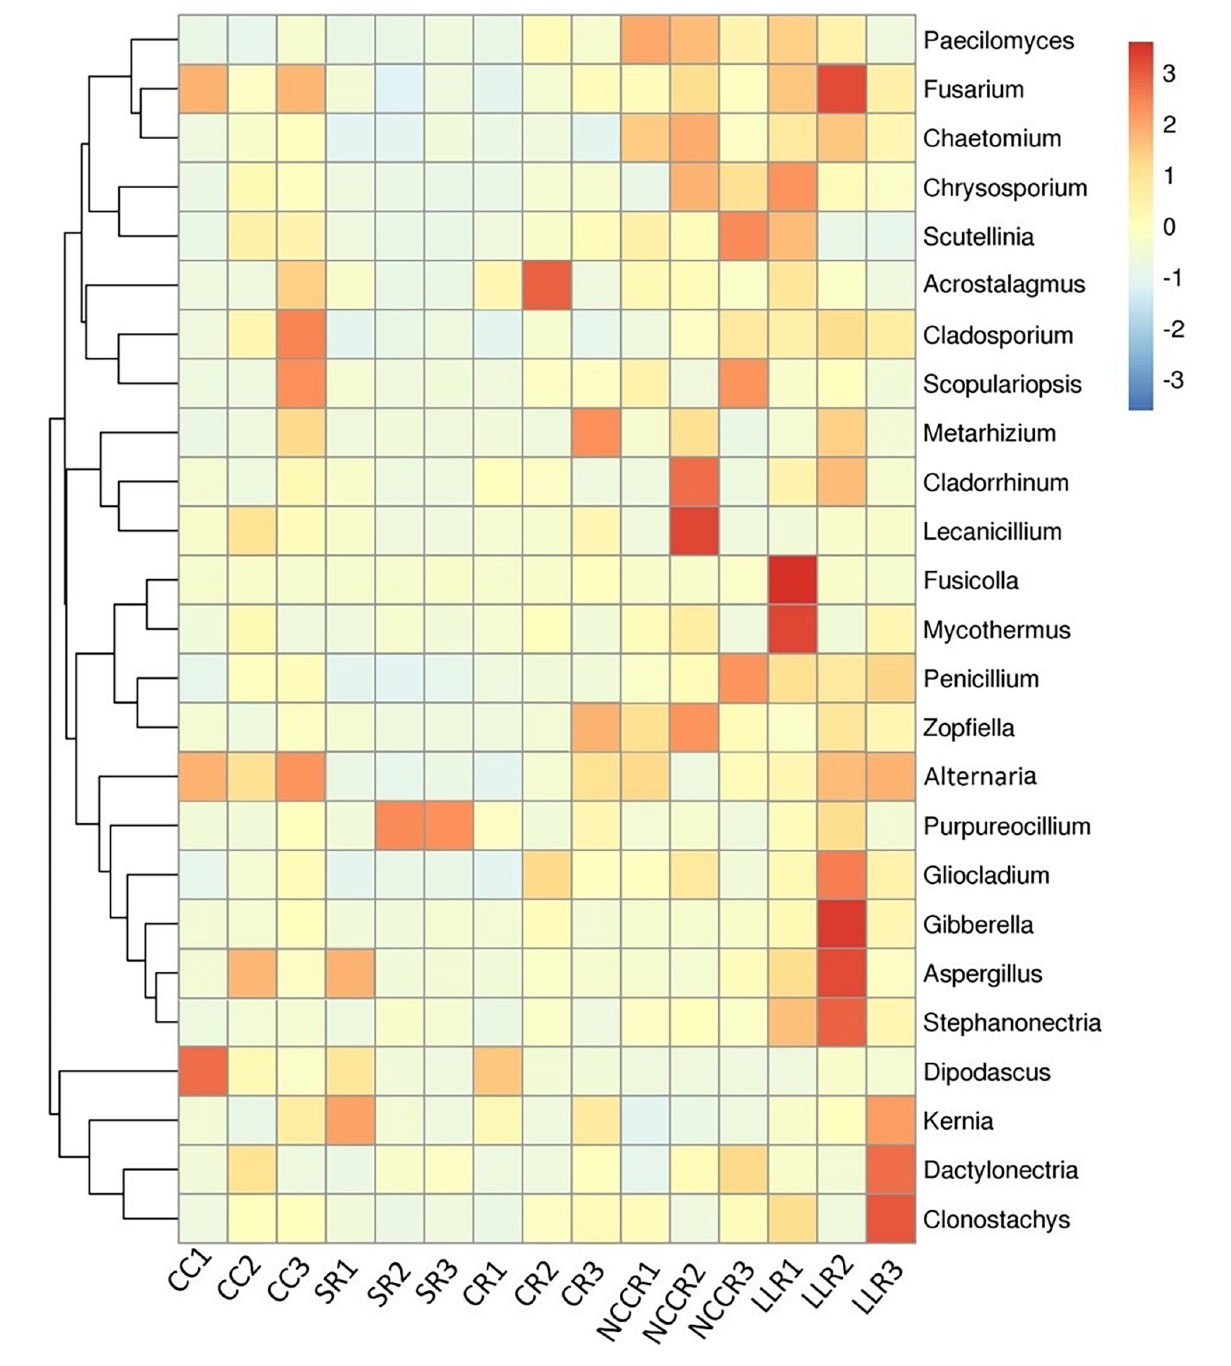
FIGURE 4 | Heatmap of top 25 dominant genera of soil fungal communities in the different treatment groups. The color pattern of heatmap showing the relative abundance pattern of each taxon. The blue denotes low relative abundance, and the red symbolizes high relative abundance. The treatments abbreviation are defined in Figure 3